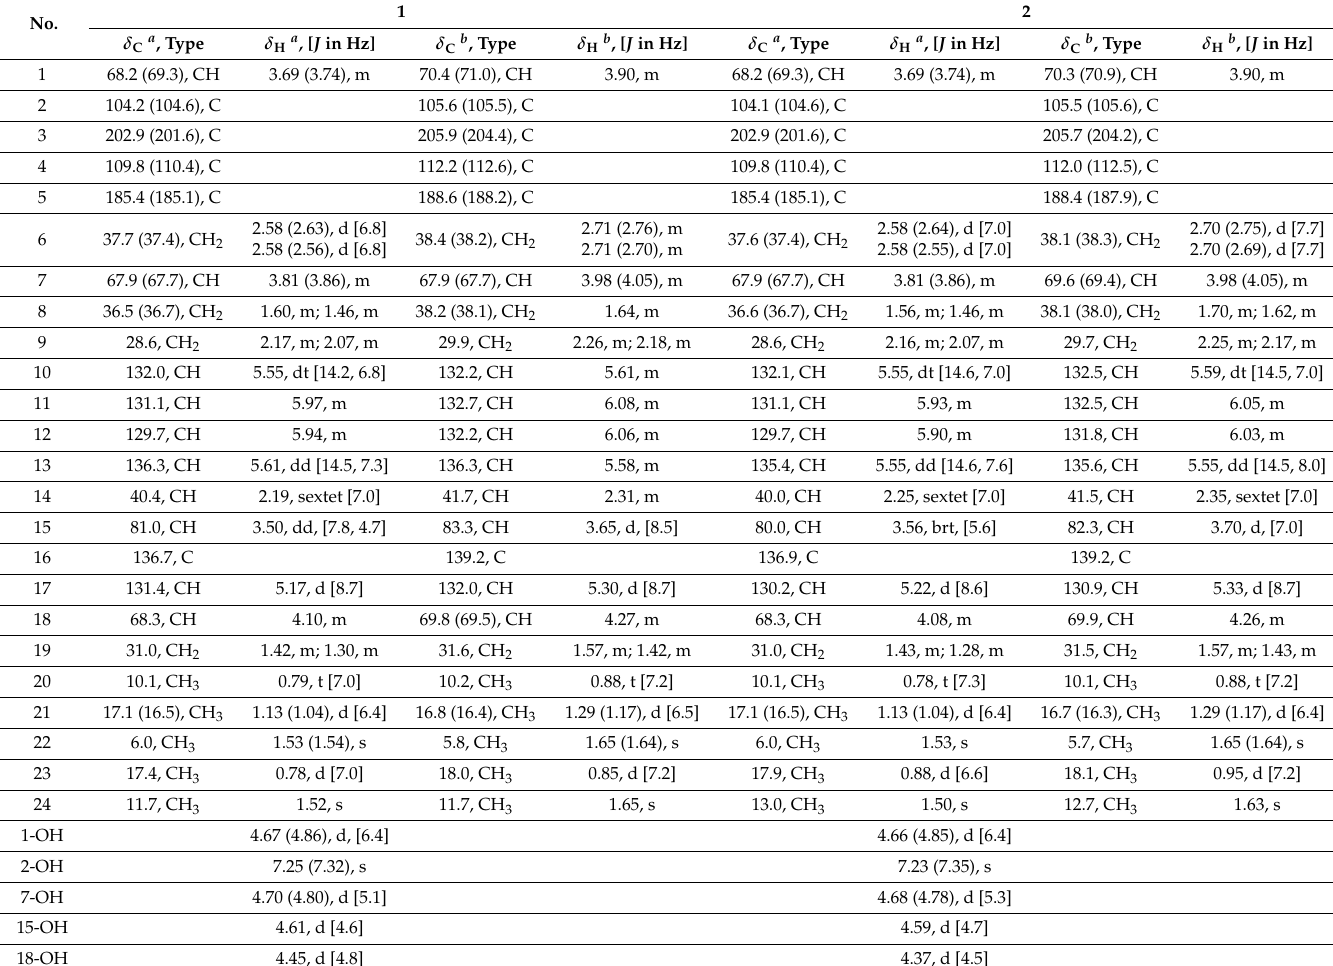
Table 1. 1 H-NMR (600 MHz) and 13 C-NMR (150 MHz) data of compounds 1 and 2